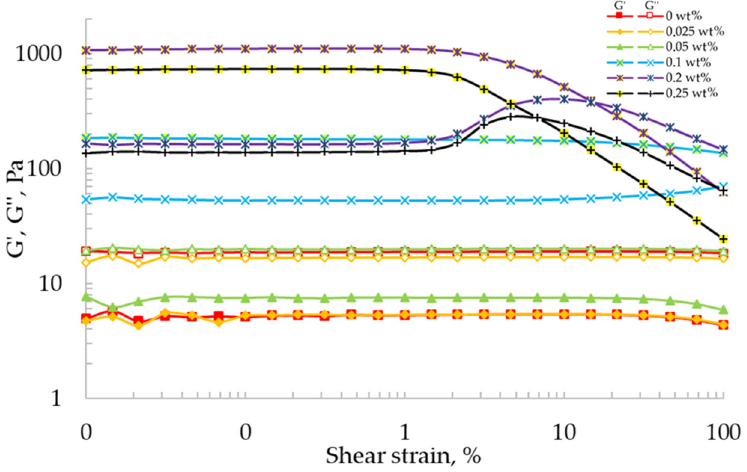
Figure 2. Storage (G′—open symbols) and loss (G″—solid symbols) modulus as a function of shear strain for the 2 wt% alginate solution and gel-like materials with concentrations of calcium chloride 0, 0.025, 0.05, 0.1, 0.2, and 0.25 wt% (logarithmic axes).